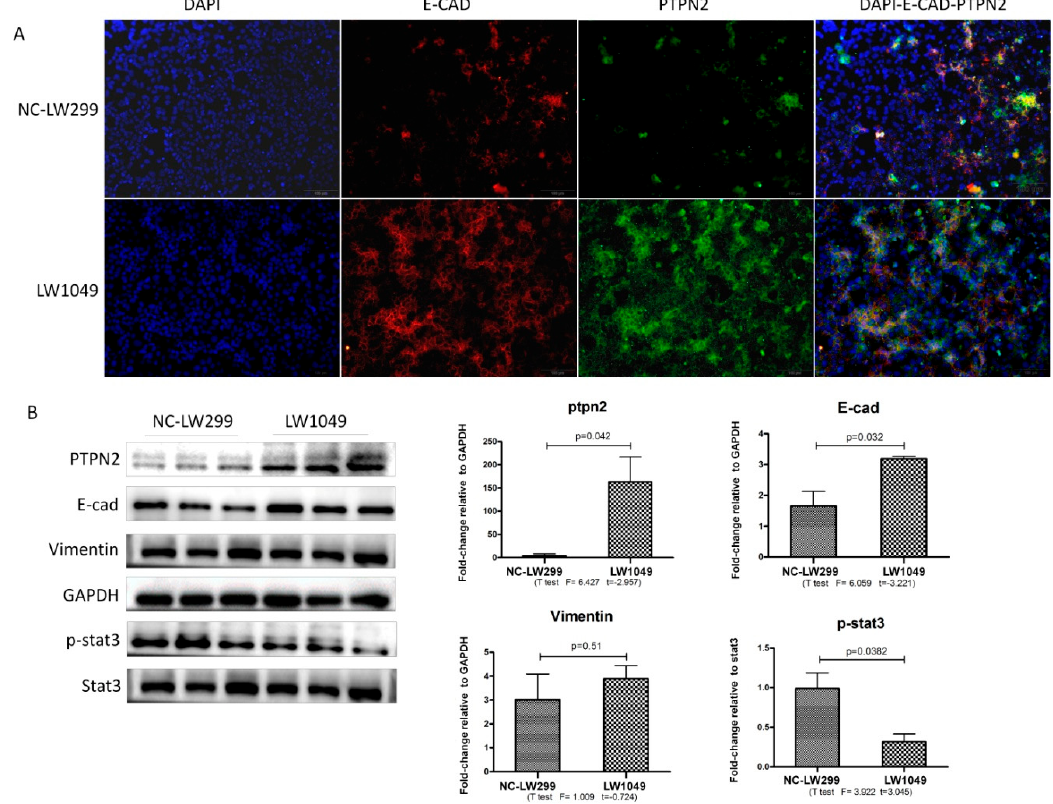
Figure 5. E ff ect of PTPN2 overexpression on MLE-12 cells. ( A ) Immunofluorescent staining of PTPN2 and E-cad expression for the PTPN2 overexpression (LW1049) and negative control (NC-LW1049) groups; Scale bars: 100 µ m. ( B ) Western blot for the expression levels of PTPN2, E-cad, Vimentin, and p-STAT3 in the NC-LW299 and LW1049 cells. Statistical analysis was performed using a t -test with SPSS20.